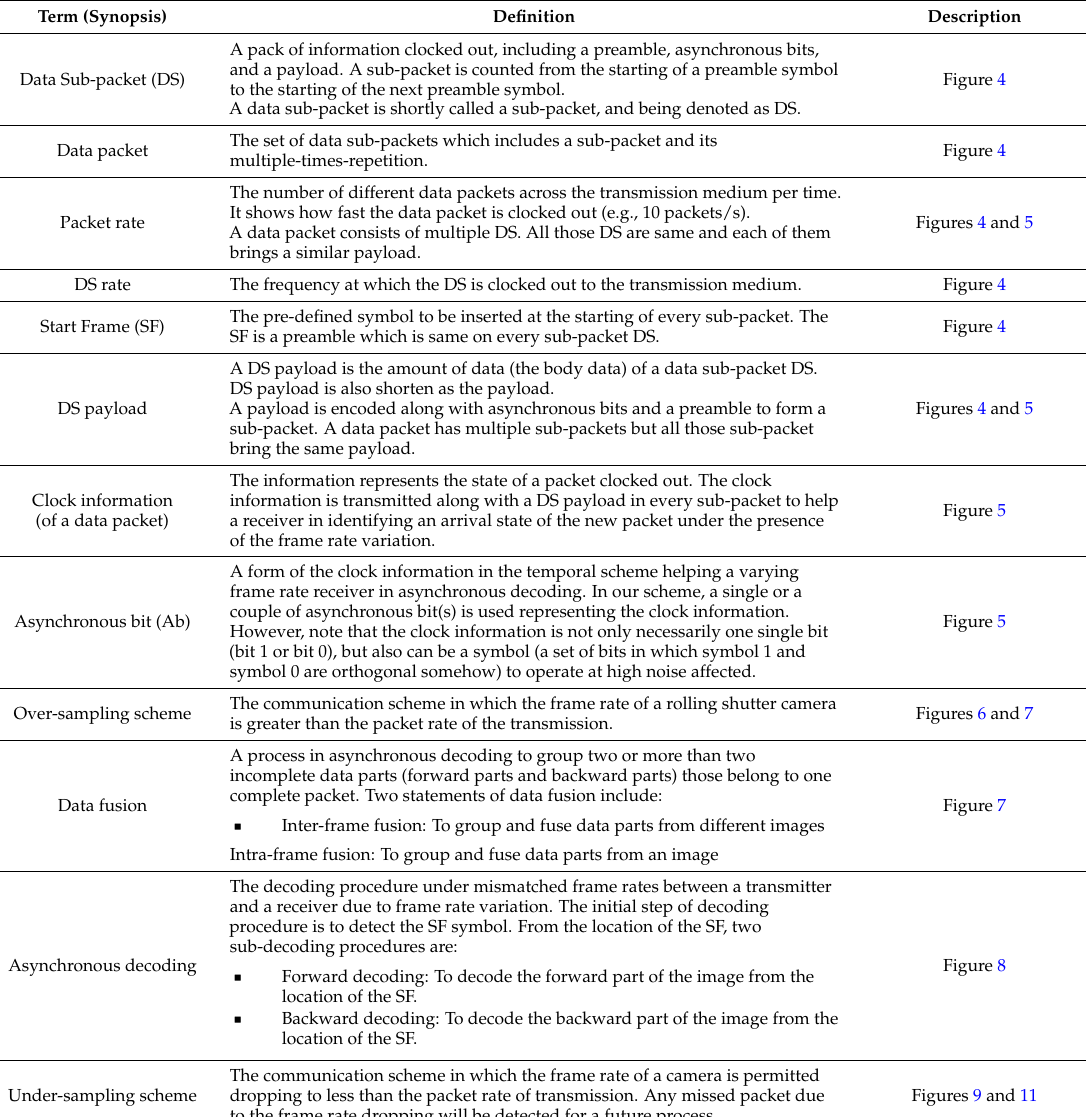
Table 3. Definitions used in our temporal encoding